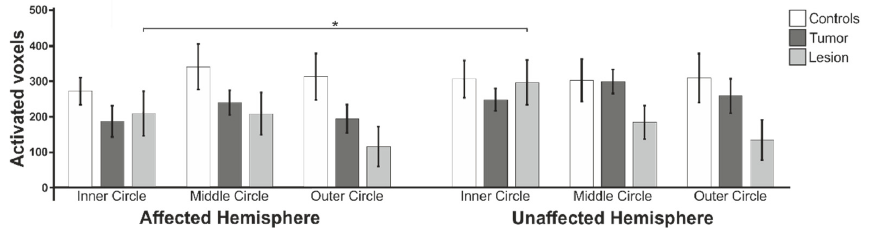
Figure 7. Mean cluster sizes of the activated voxels within the Calcarine fissure compared between the control, tumor patient and lesion patient groups. Statistically significant results are marked with * for p < 0.05.